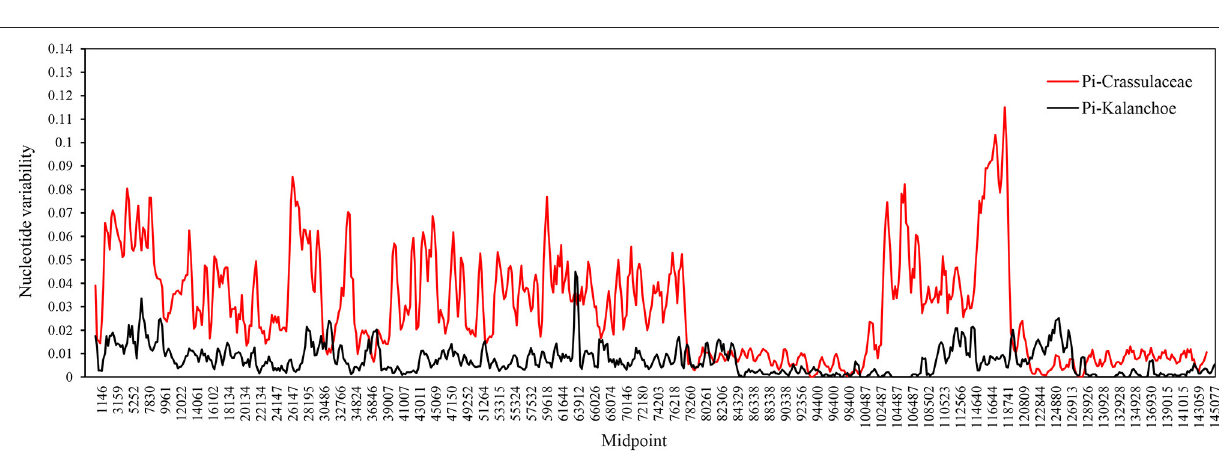
found between the IR boundaries within the LSC (IRb: rps19